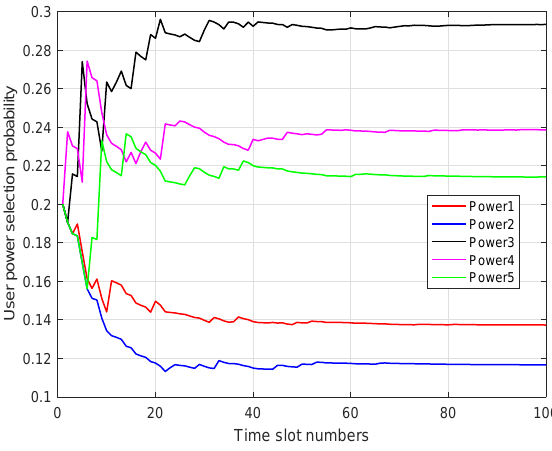
Figure 4. User power selection